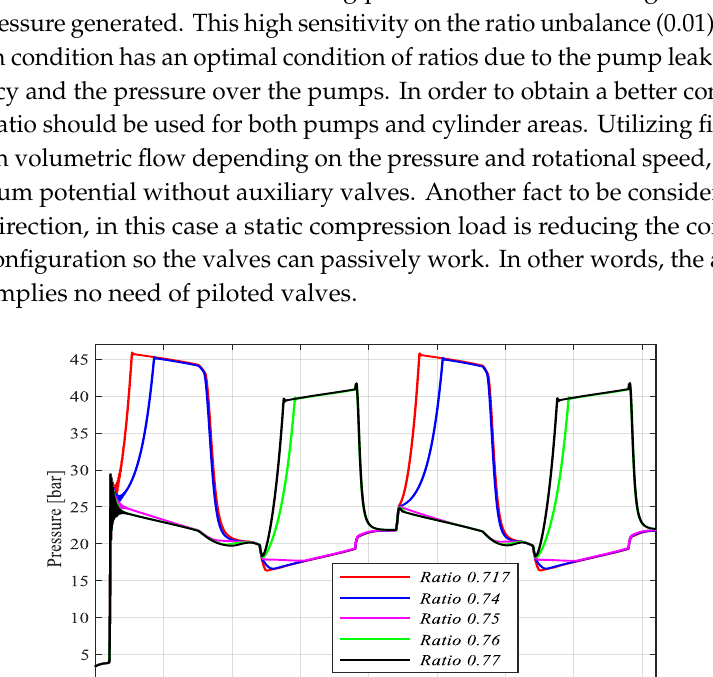
Figure 12. Cylinder position (600 rpm).